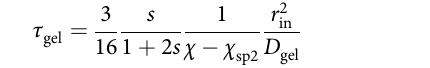
only by the distance r in during the deformation. This fact is